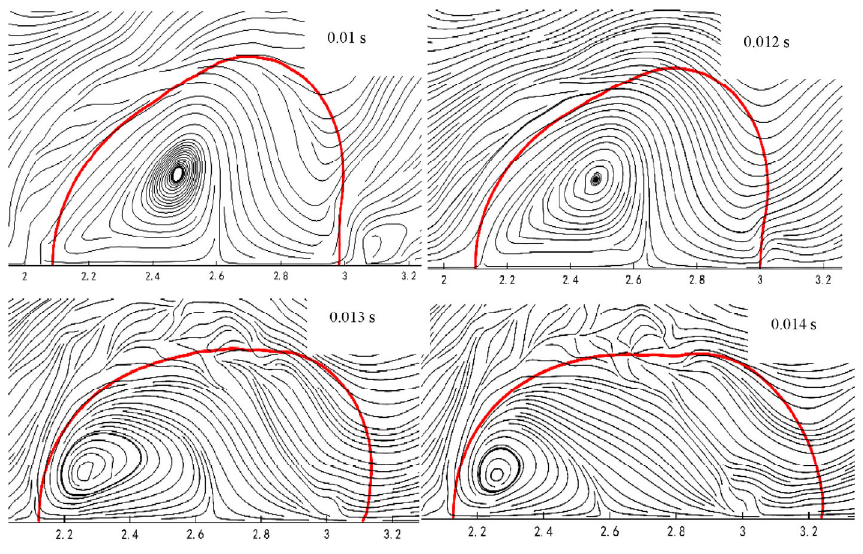
Fig. 8 Change of interface shape during silicone oil